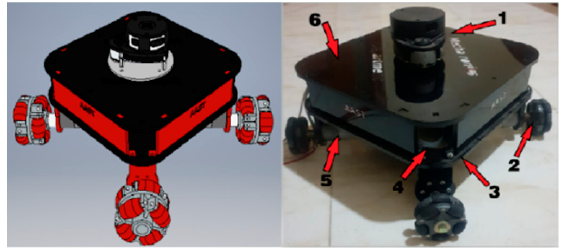
Figure 1. Omni-wheel mobile robot design, (1) LIDAR sensor, (2) omni-wheel, (3) lower base, (4) control boX, (5) motor & encoder, (6) upper base.